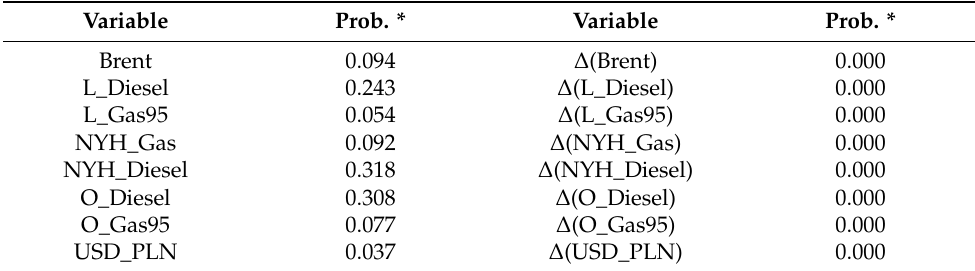
Table 3. ADF test results—levels and first differences. Variable Prob. * Variable